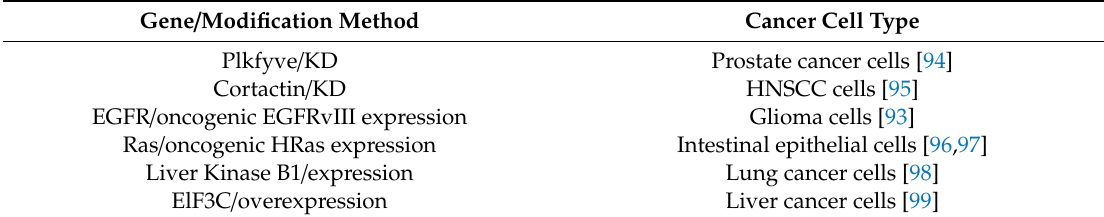
Table 4. List of genes that are involved in exosome